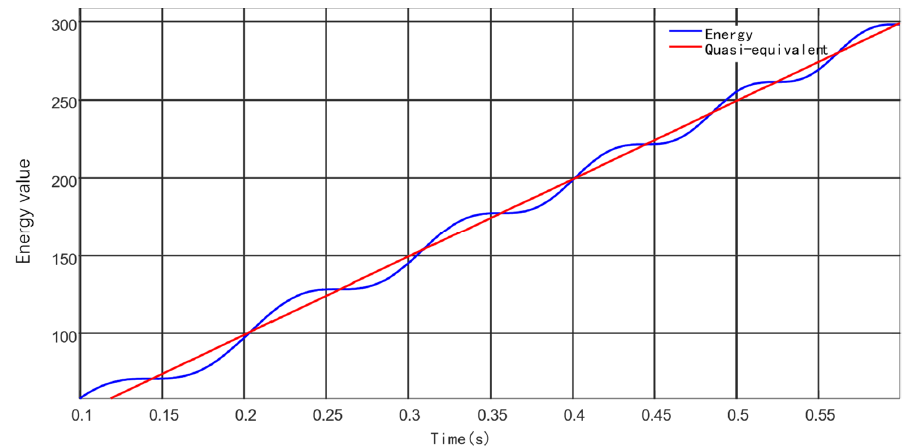
Figure 5. Schematic diagram of the time ‐ integrated curve of vibroseis energy.